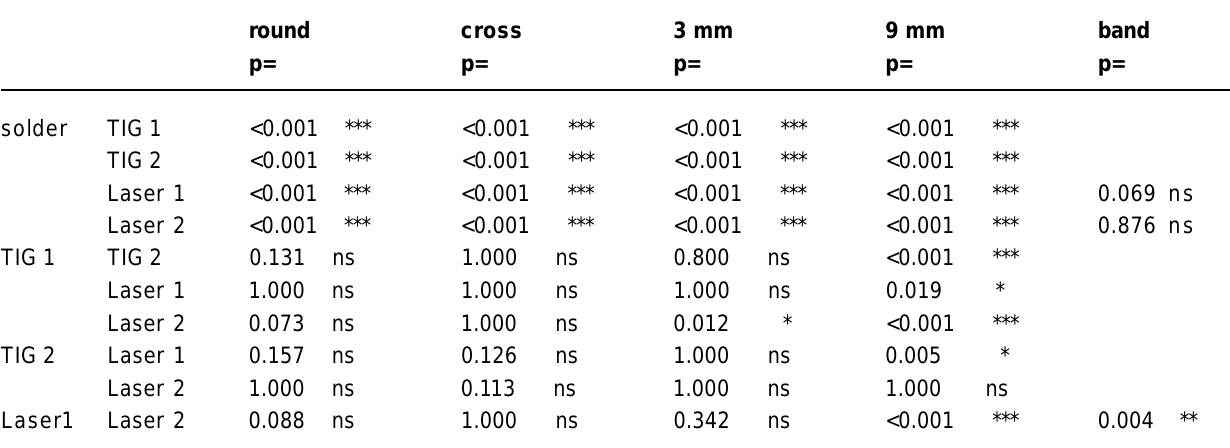
TABLE 6- Results of Bonferroni post hoc